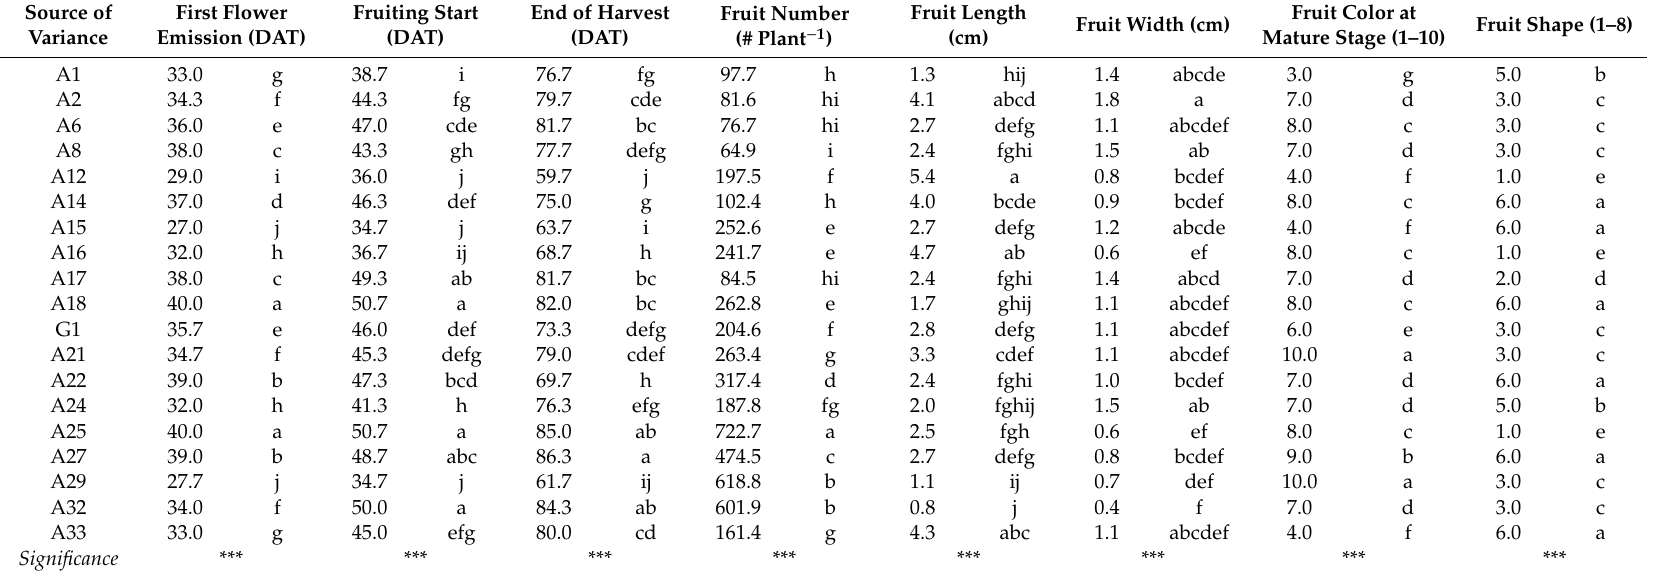
Table 3. E ff ect of 19 chili pepper accessions on first flower emission, fruiting start, end of harvest fruit number, fruit length, fruit width, fruit color at mature stage and fruit shape, in